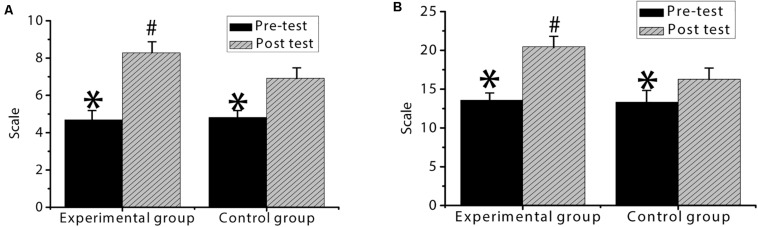
Comparison of entrepreneurial intention between the experimental group and the control group. (A) is the entrepreneurial possibility of the two groups of students; (B) is the entrepreneurial behavior tendency of the two groups. ∗ indicates that the difference is statistically significant compared with the post-test entrepreneurial intention (p < 0.05); # indicates that the difference is statistically significant compared to the control group (p < 0.05).